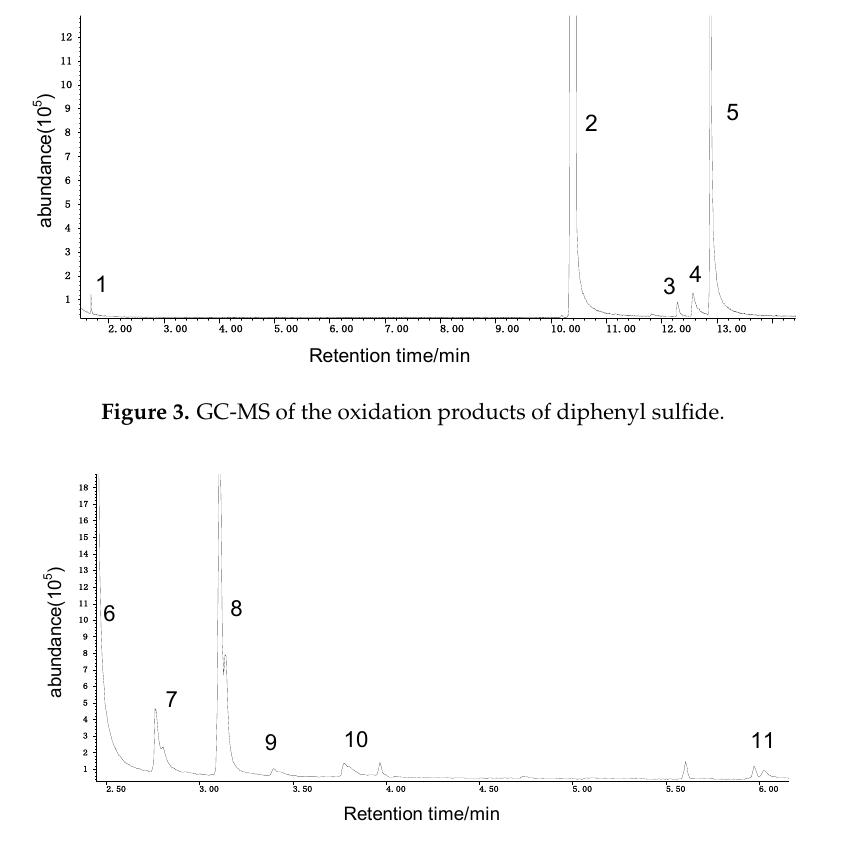
Figure 2. The oxidation product curve of the model compound cysteine. 2.1.3. GC/MS Analysis Results of Organic Sulfur Model Compounds In this paper, the acetone extract from the low-temp oxidation residues of diphenyl sulfide and cysteine are analyzed using GC/MS. Table 1 shows the name and structure of the peaks marked in Figures 3 and 4.